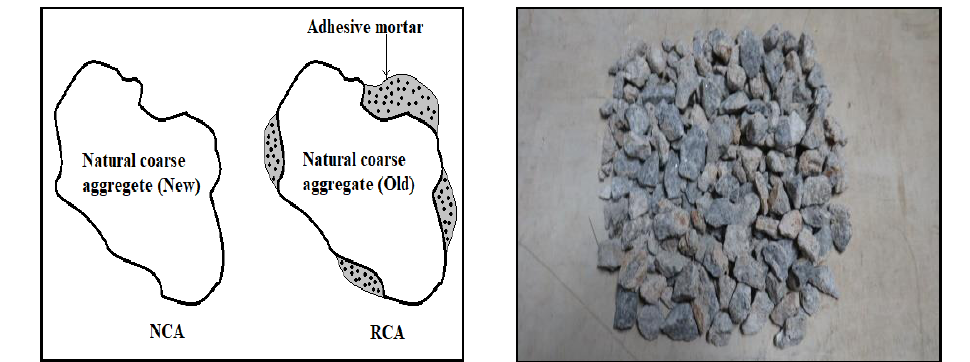
Figure 1. Recycled